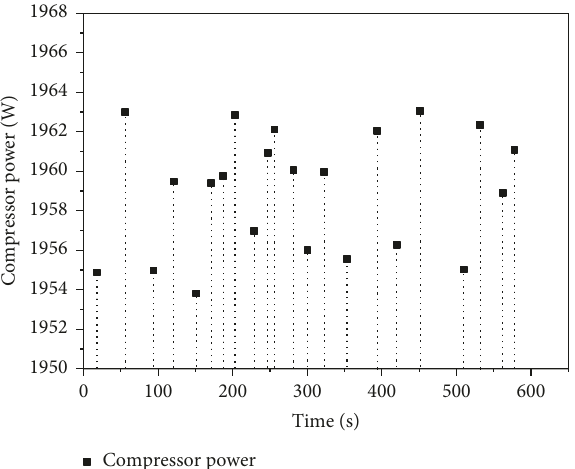
Figure 12: Stability test of compressor electrical power.